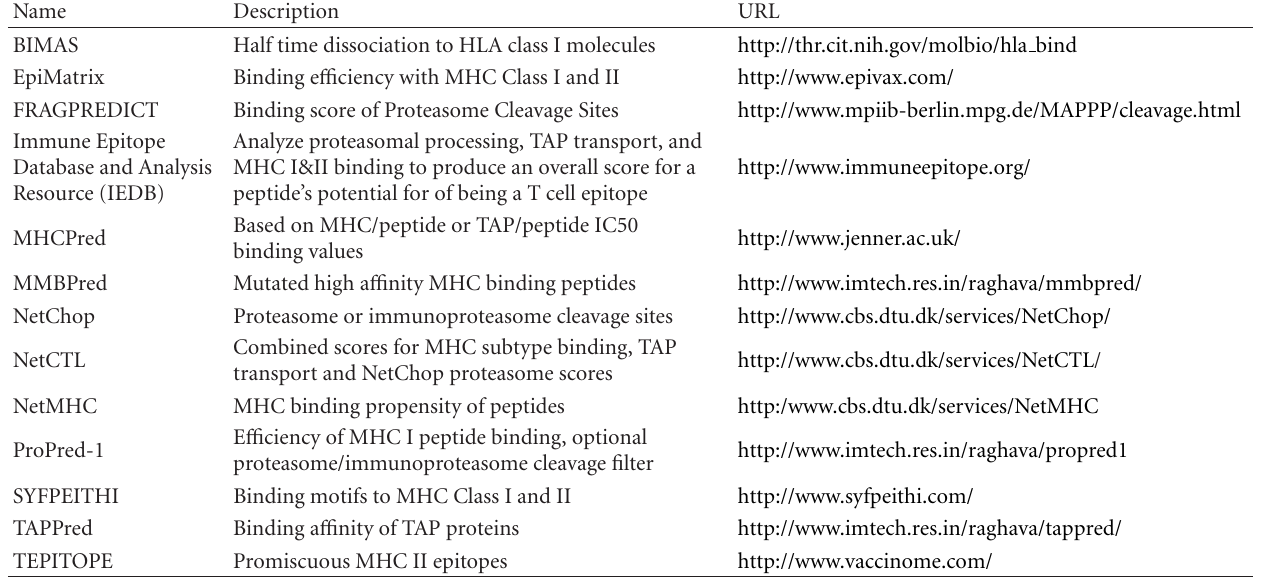
Table 2: T-cell epitope prediction tools. This table, adapted from Table 1 [165], summarizes available websites for T-cell epitope prediction. The prediction mechanisms employed, URLs, or authors’ email addresses are included. Detailed descriptions and references are included in the